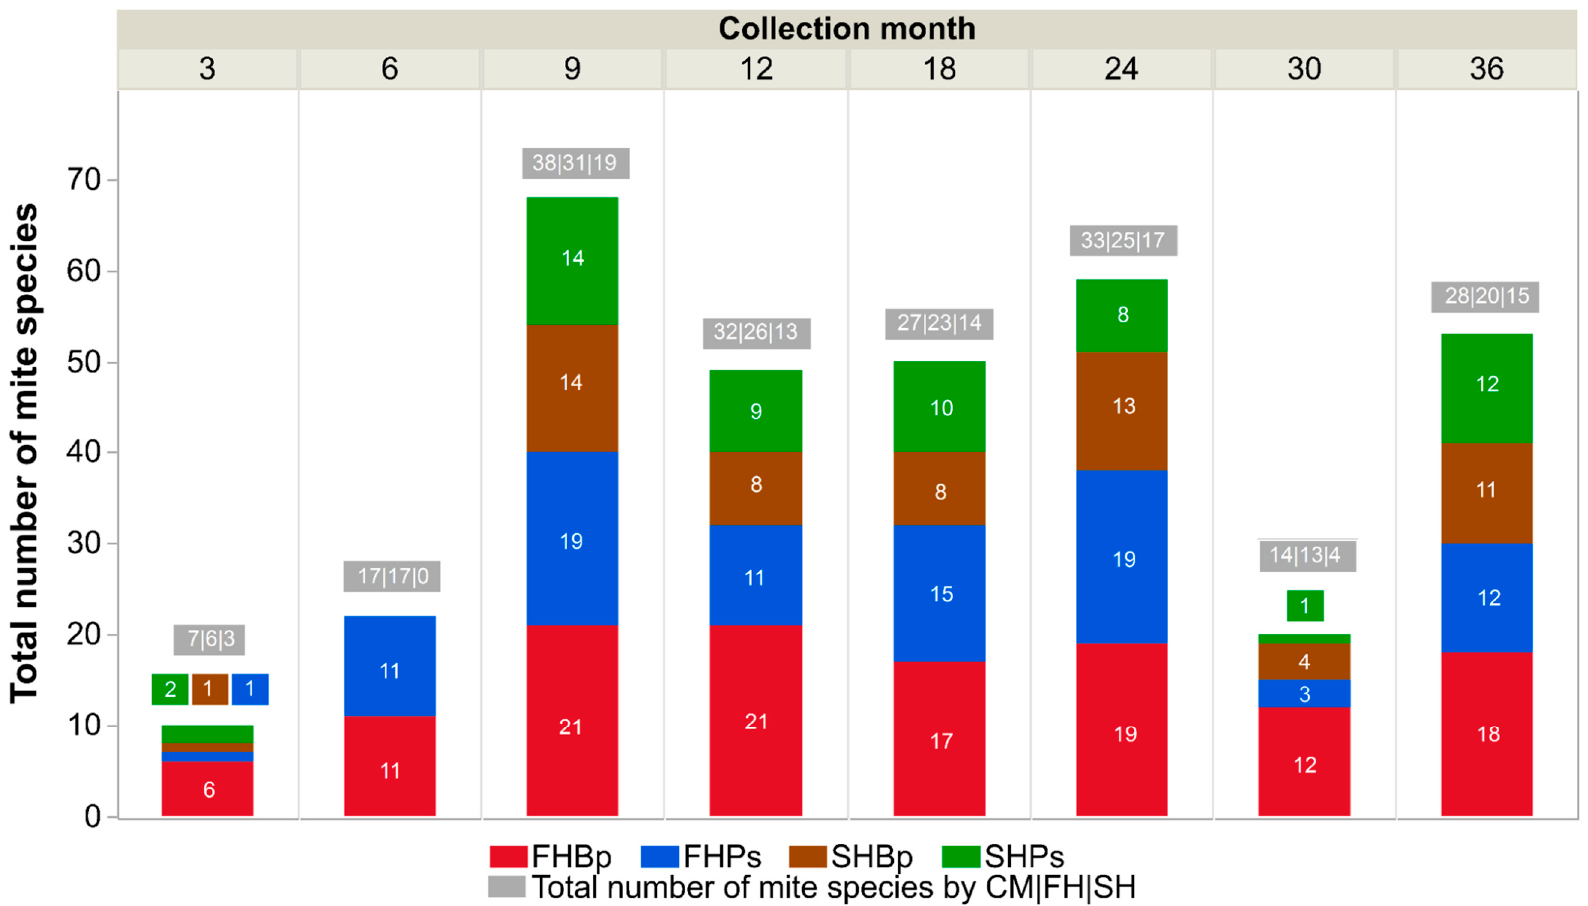
Figure 2. Total number of mite species recorded in Betula pendula (Bp) and Pinus sylvestris (Ps) stands growing in forest habitat (FH) and spoil heap (SH). Data are shown for each collection month (CM) during the experiment. When total abundance was very low, we have added numbers and respective colors above the bars.